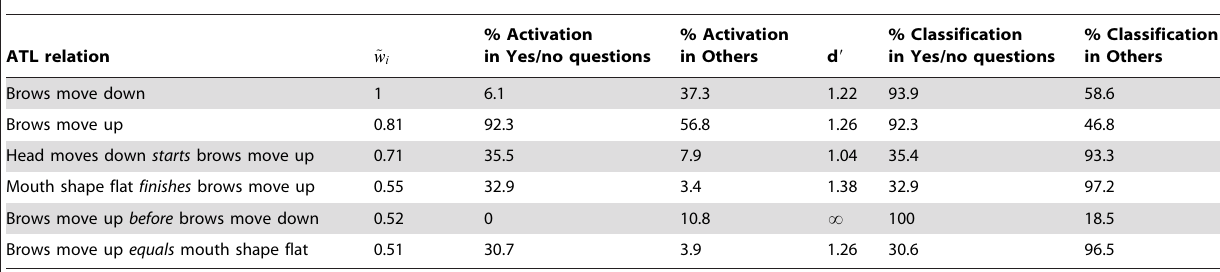
Table 6. Discriminant features for Yes/no-questions.